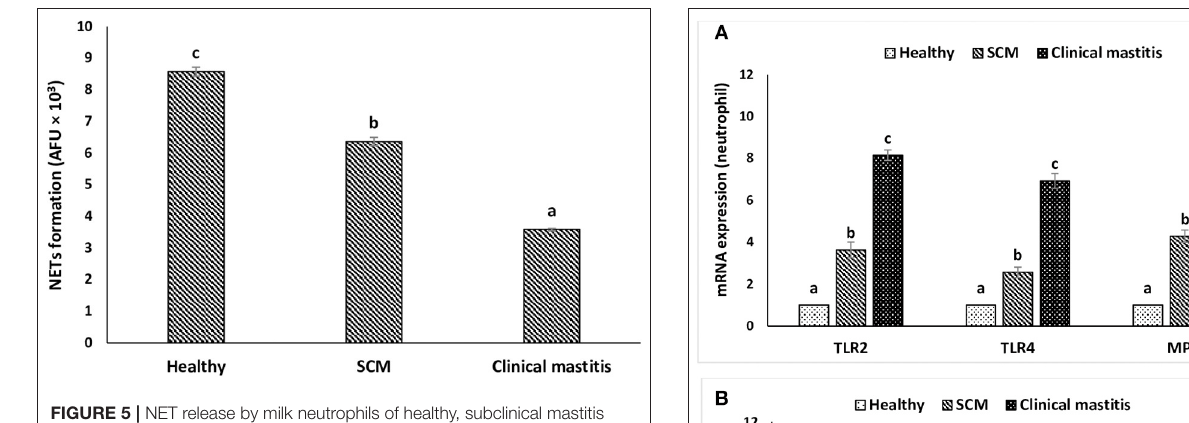
FIGURE 5 | NET release by milk neutrophils of healthy, subclinical mastitis (SCM), and clinical mastitis Sahiwal cows. Extracellular DNA quantifications of supernatants from milk neutrophils following zymosan treatment (1 mg/mL, 3h) using fluorometric DNA quantification assay (PicoGreen). Data were expressed as mean ± SEM. Means statistically ( p < 0.05) different between the groups are shown with small superscript letters (a–c).